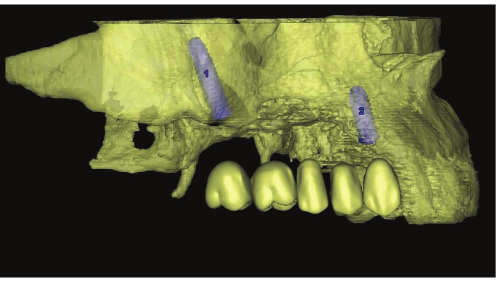
Figure 3: Preoperative simulation of implant planning.